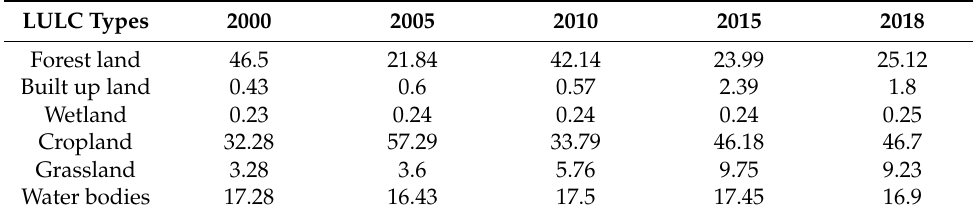
Figure 10. Change detection in LULC: ( a ) 2000, ( b ) 2005, ( c ) 2010, ( d ) 2015 and ( e ) 2018. Table 5. Statistical changes for LULC